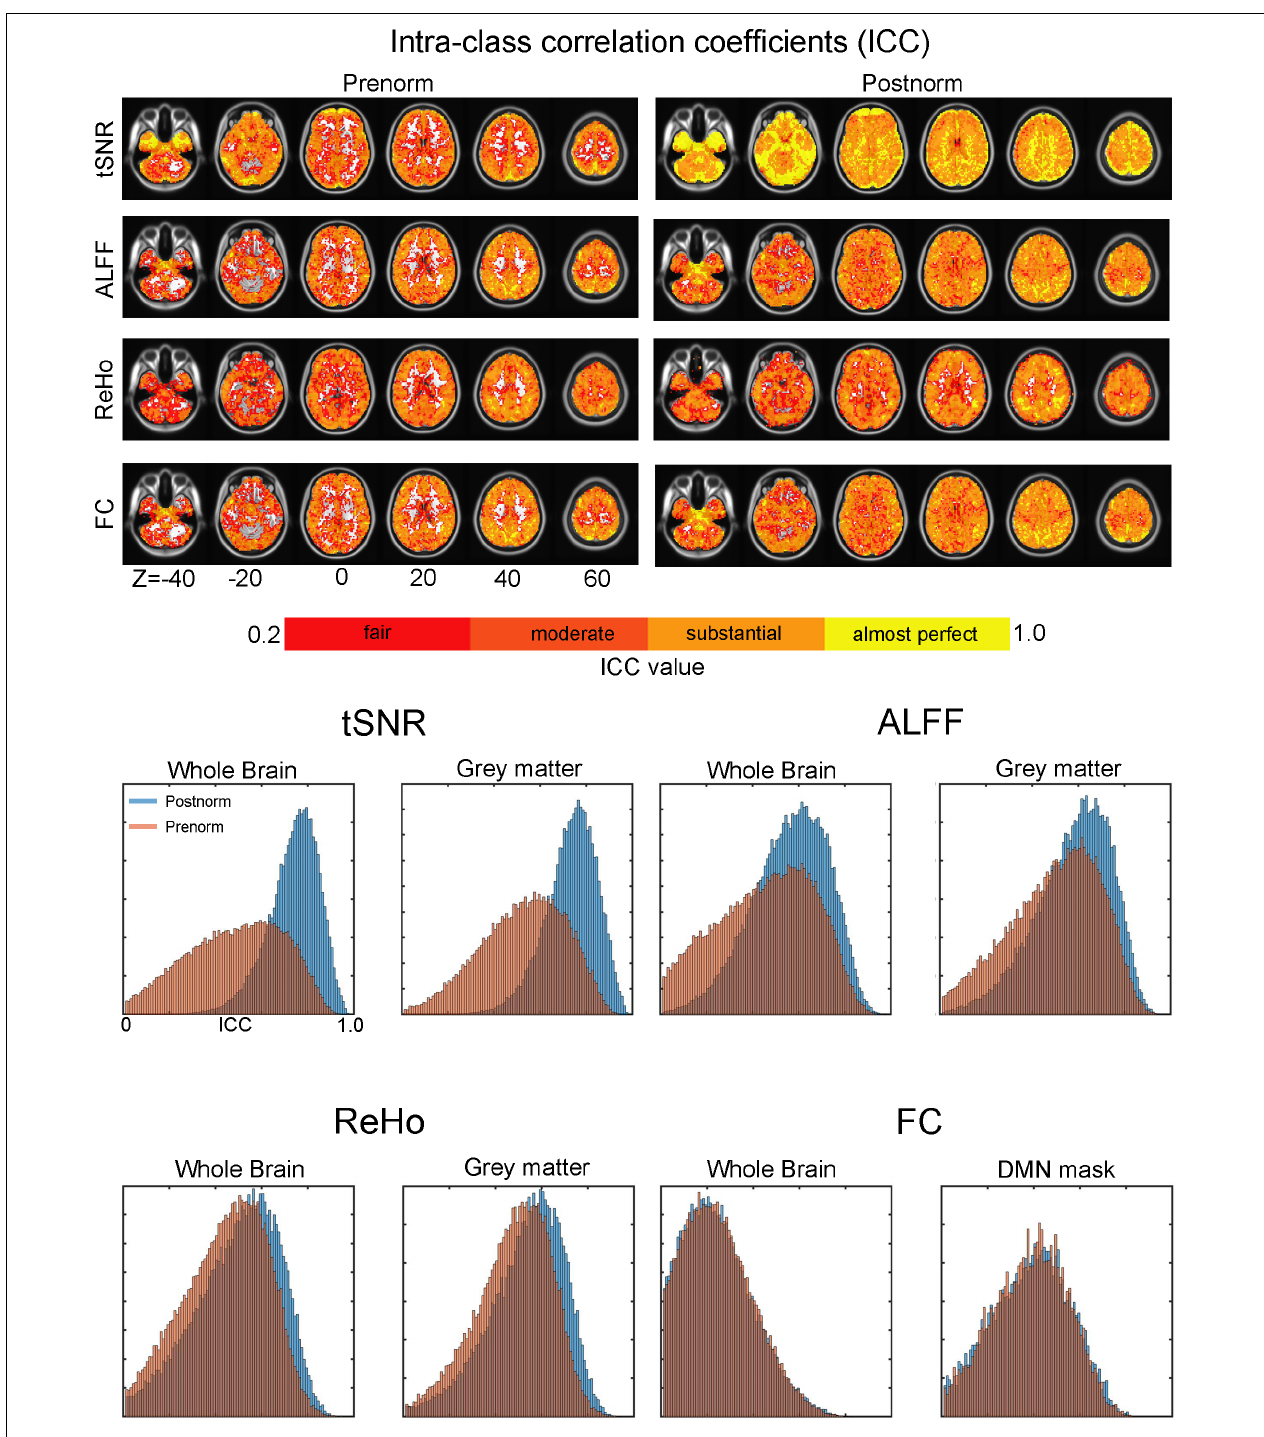
FIGURE 4 | Effect of normalization strategies on intraclass correlation coefficients (ICCs) of the amplitude of low-frequency fluctuation (ALFF), regional homogeneity (ReHo), and functional connectivity (FC). (Upper) The left column showed the ICC values in each voxel after Prenorm and the right column for Postnorm. Each row for temporal signal-to-noise ratio (tSNR), ALFF, ReHo, and FC, respectively. The “fair reliability” mean means 0.2 < ICC < 0.4, “moderate” means 0.4 < ICC < 0.6, “substantial” means 0.6 < ICC < 0.8, and “almost perfect” means ICC > 0.8. (Bottom) Histogram of ICC. For each rs-fMRI index, the histograms of ICC for both normalization strategies were shown. For tSNR, ALFF, and ReHo, histograms within whole brain and gray matter regions were illustrated. For FC, besides whole brain, we focused on default mode network (DMN) regions to exclude regions with the very small FC values, as well as the controversial negative FC regions. According to a paired t -test, ICC of tSNR, ALFF, and ReHo is significantly higher when Postnorm is used compared to those when Prenorm is used. In contrast, FC showed no significant difference.